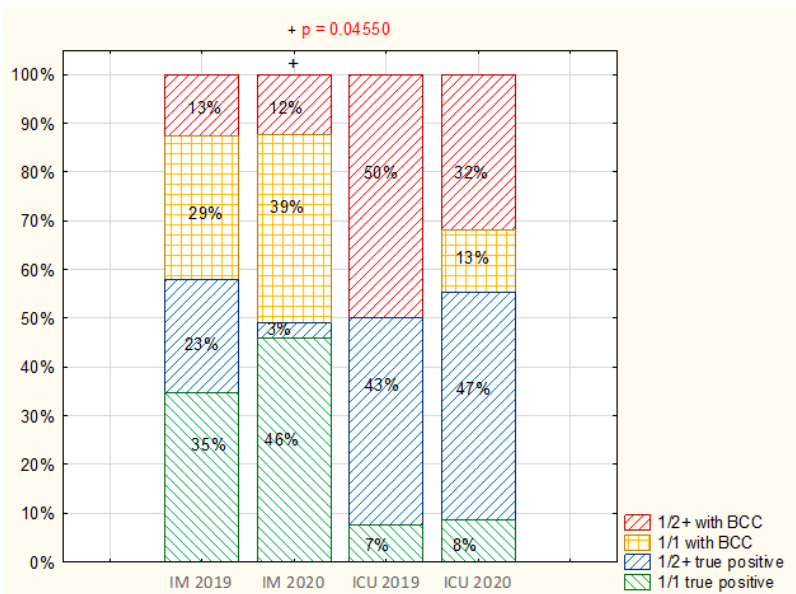
Figure 6. Comparison of the percentage of single (1/1) and the percentage of at least double (1/2+) sets with BCC and with infection (true positive) (analysis without negative samples) in the Internal Medicine (IM) department and Intensive Care Unit (ICU) in 2019 and 2020.